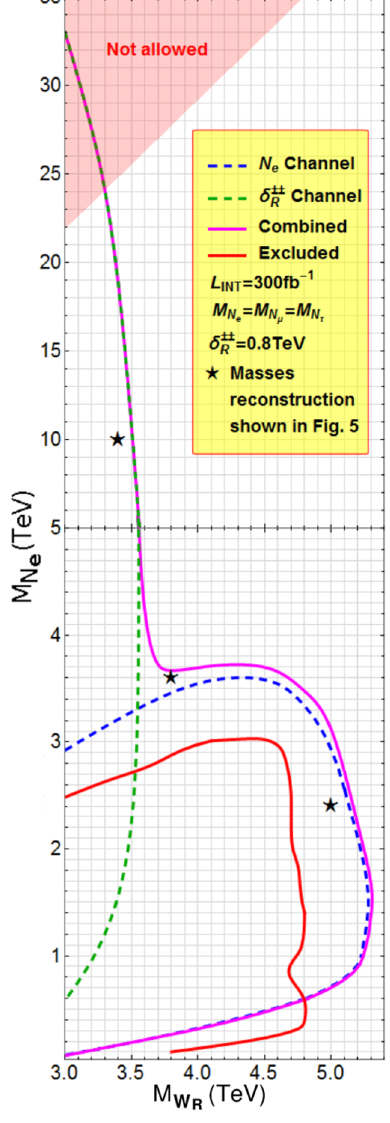
Figure 6 . Discovery potential for the two dominant channels of the pp → W R → e ± e ± jj process at the 14 TeV LHC for an integrated luminosity of 300 fb − 1 . The coordinates denoted by F correspond to the three mass settings of figure 5. The red line boundary of the excluded area (i.e. the mass region where no excess of like-sign dilepton events in comparison to the SM was found) is based on the works in refs. [54–57]. The lower and the upper part of the y-axis have different (linear) scales in order to highlight the independent and the combined sensitivity regions associated with the two